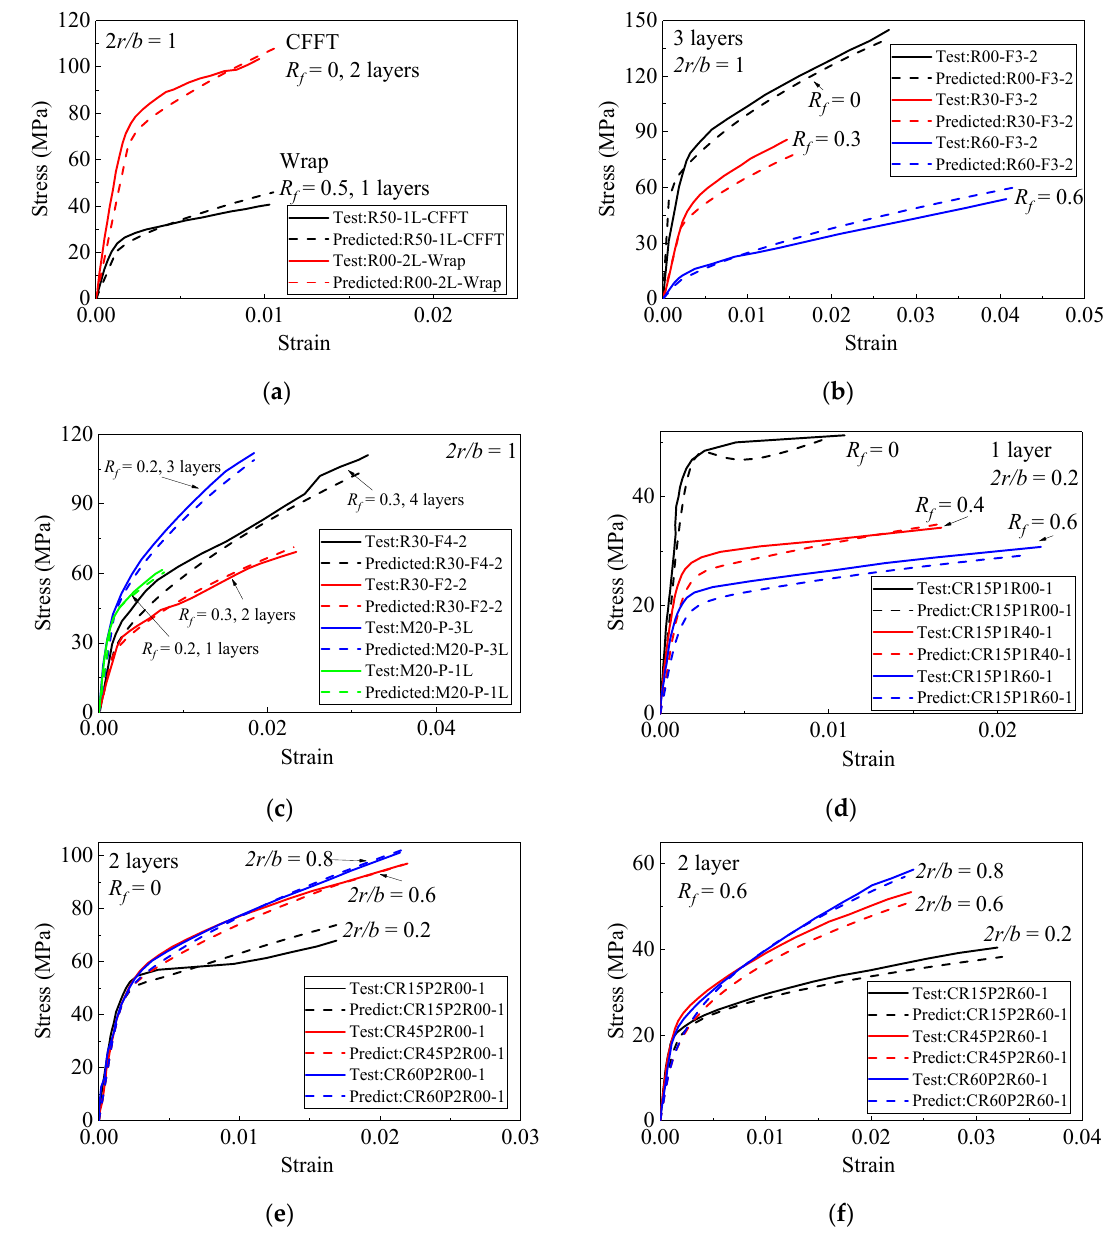
Figure 7. Performance of the proposed model for square normal concrete and RuC columns. ( a ) Speci- mens with different FRP retrofit methods [18]. ( b ) Specimens with different rubber content [11]. ( c ) Specimens with different FRP layers. (R30-F4-2, R30-F2-2 [11] and M20-P-3L, M20-P-1L [19]). ( d ) Specimens with different FRP layers [15]. ( e ) Specimens with different corner radii [15]. ( f ) Speci- mens with different corner radii [15].